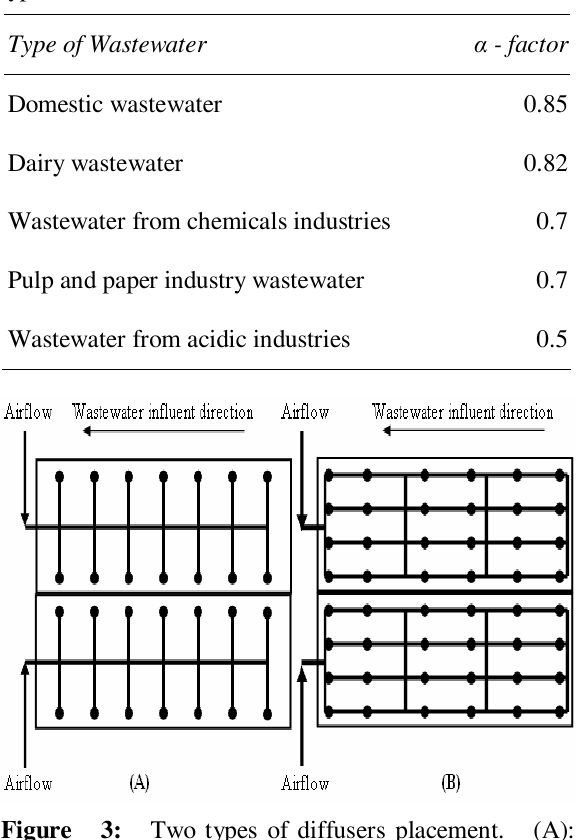
Table 1: Values of the correction factor for some types of wastewater [15]